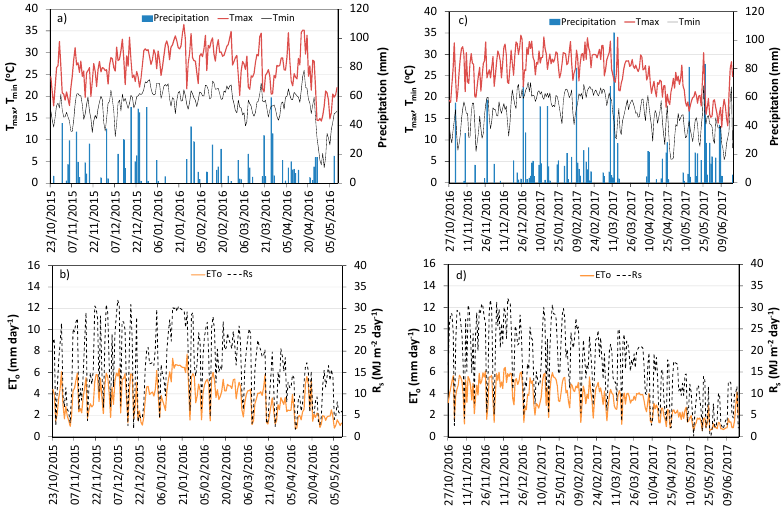
Figure 1. Daily weather data during the crop seasons of 2015/16 and 2016/17: ( a , c ) maximum ( ▬ ) and minimum (––) temperatures, and rainfall ( ▬ ); ( b , d ) solar radiation (--) and reference evapotranspiration ( ▬ ).